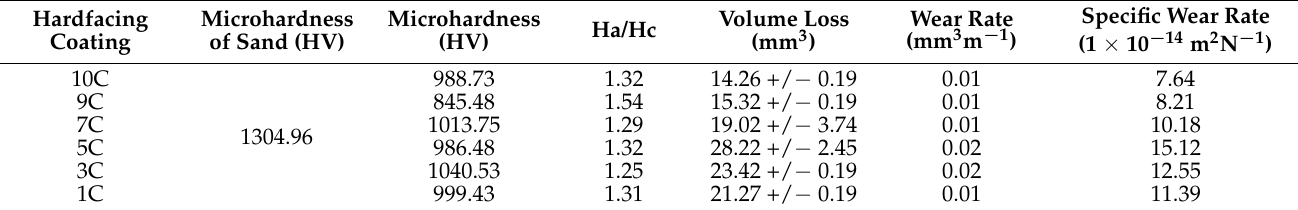
Table 8. Results of wear tests according to the international ASTM G65 standard for hardfacing alloy sintered under different atmospheres. Hardfacing Microhardness Coating of Sand (HV)